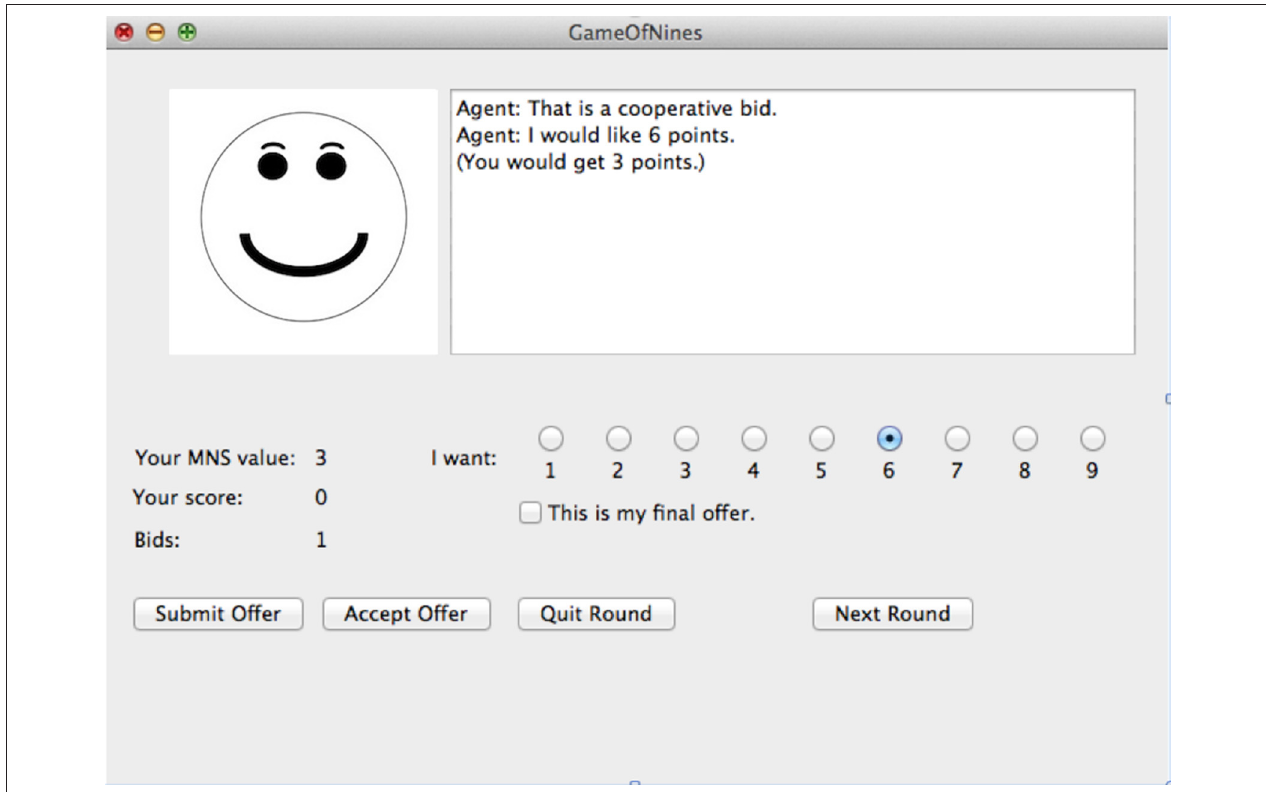
FIGURE 11 | A screenshot from the model in the feedback condition. In the no-feedback condition, no face was shown on the left side and statements evaluating the player’s move (e.g., “That is a cooperative bid.”) did not appear.